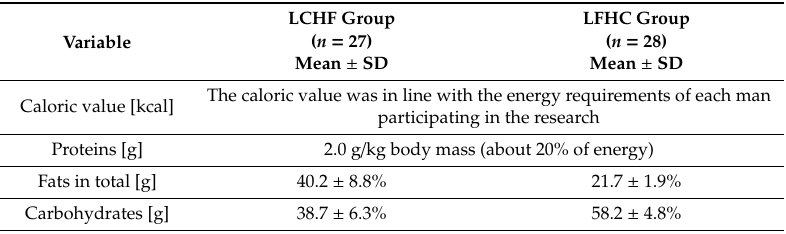
Table 1. General characteristic of interventional